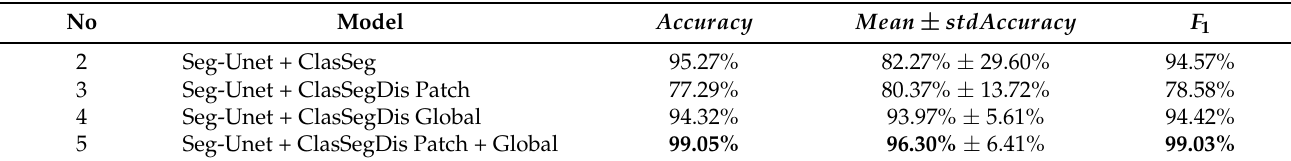
Table 4. Classification results of the CNUH dataset on the validation